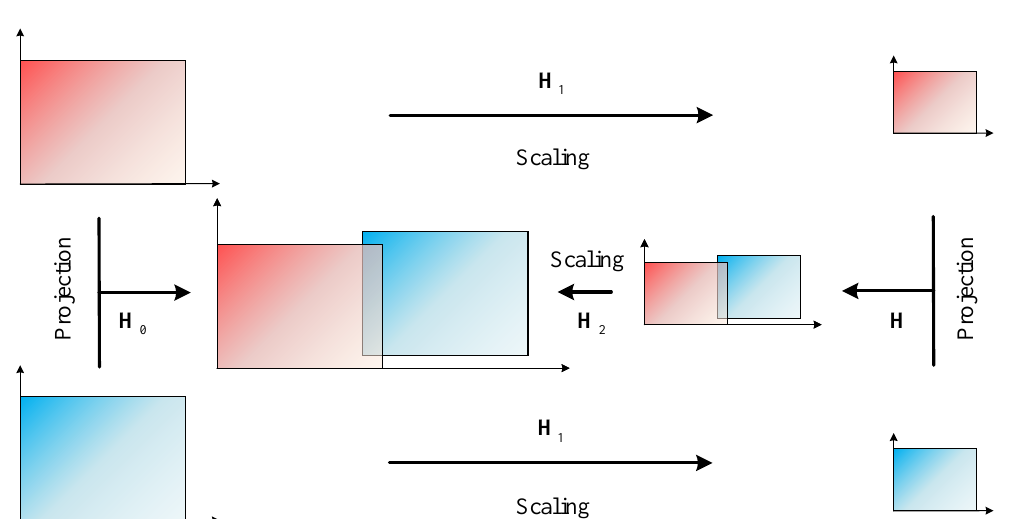
Figure 5. The relationship of image scaling and homography matrix scaling. Therefore, the homography matrix used to project the original image I β to the original image I α can be shown